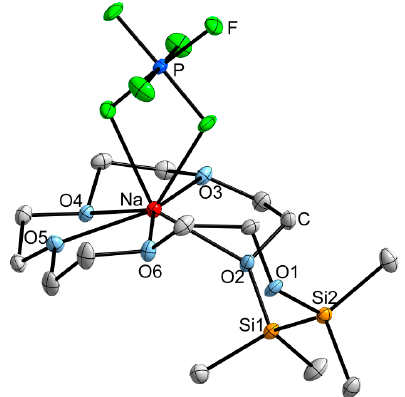
Figure 3. Molecular structure of [Na(1,2-disila[18]crown-6)PF 6 ] ( 2 ) in the crystal. Thermal ellipsoids represent the 50% probability level. Hydrogen atoms are not displayed. Selected bond lengths (pm) and angles ( ◦ ): Na ··· O1: 453.2(3), Na–O2: 238.5(3), Na–O3: 247.3(2), Na–O4: 244.9(3),